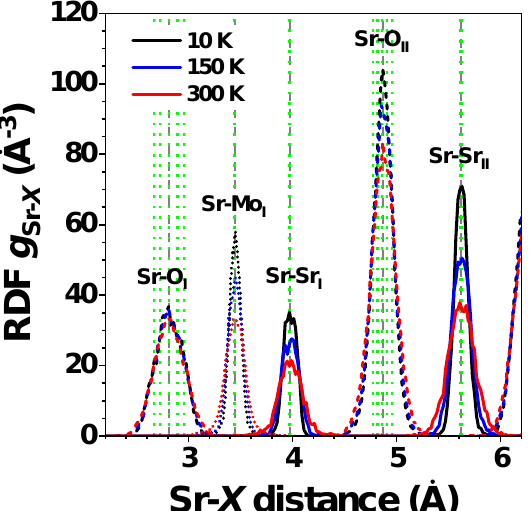
Figure 4. Radial distribution functions (RDFs) g Sr- X ( r ) in polycrystalline SrMoO 3 at 10 K, 150 K, and 300 K. Green and grey vertical dashed lines correspond to the average inter-atomic distances as obtained by XRD at 5 and 300 K, respectively. See text for